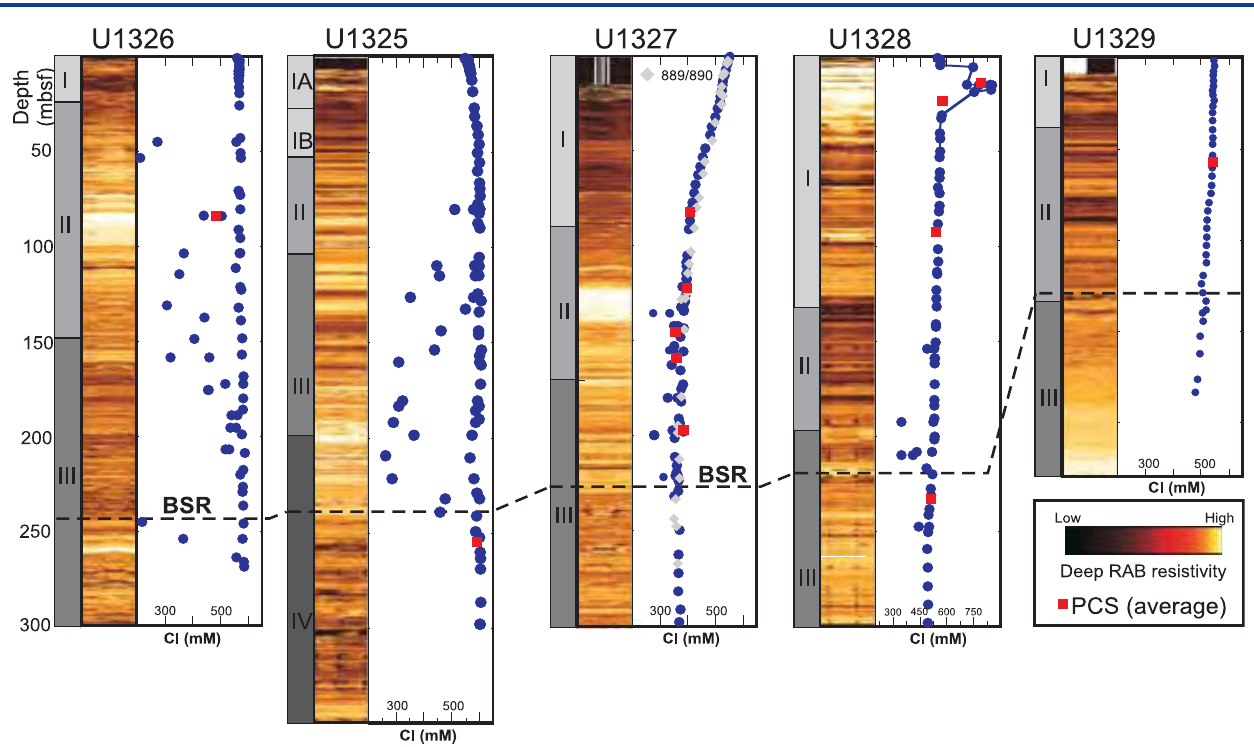
Figure 2. Summary of IODP Expedition 311 pore-water chlorinity profi les, including average chlorinity from PCS core. ODP Site 889 and 890 data are shown for comparison. Also shown are lithostratigraphic units, LWD RAB resistivity images, and location of